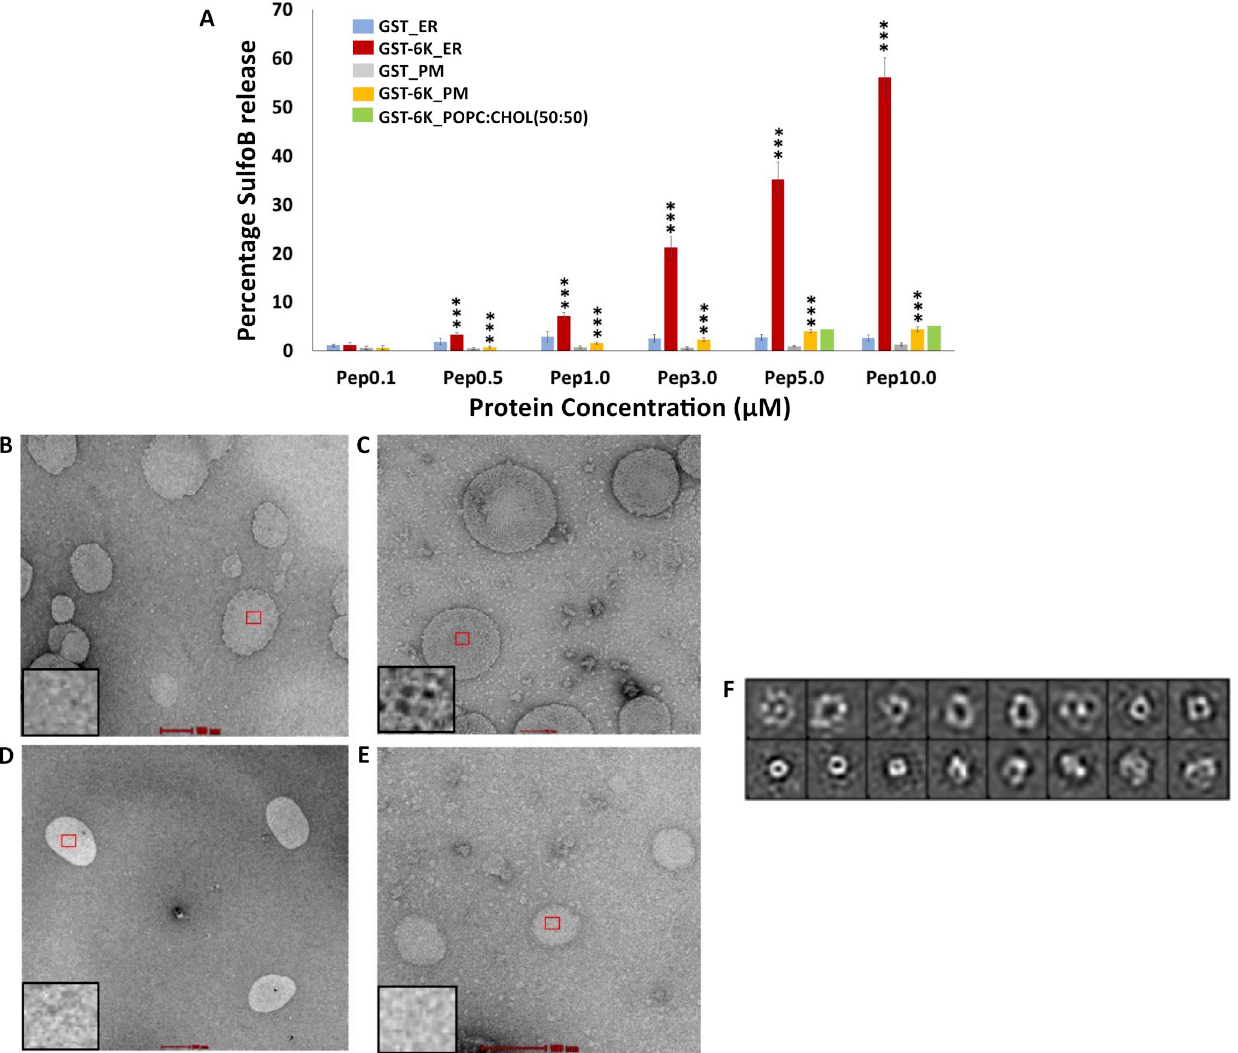
Fig 3. Liposome disruption assays and visualization of GST-6K on organelle mimicking lipid membranes: (A) Plot showing the percentage release of sulforhodamine B from liposomes by GST-6K at concentrations ranging from 0.1–10 μ M. Data is represented as mean of triplicate independent samples ± SD ( ��� P < 0.001; �� P < 0.01; � P < 0.05; P > 0.05 NS (Non-Significant). (B, C) Negative stain electron micrograph of GST-6K untreated and treated (5 μ M) endoplasmic reticulum mimicking liposomes and (D, E) that of plasma membrane mimicking liposomes respectively. Insets show a magnified view of the liposomal surface in each case (B-E). (F) Reference-free 2D classification of negatively stained GST-6K associated with ER liposomes.